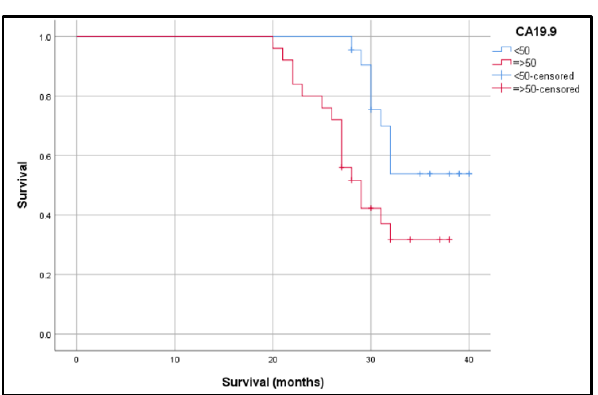
Figure 2. Overall survival curves according to CA 19.9